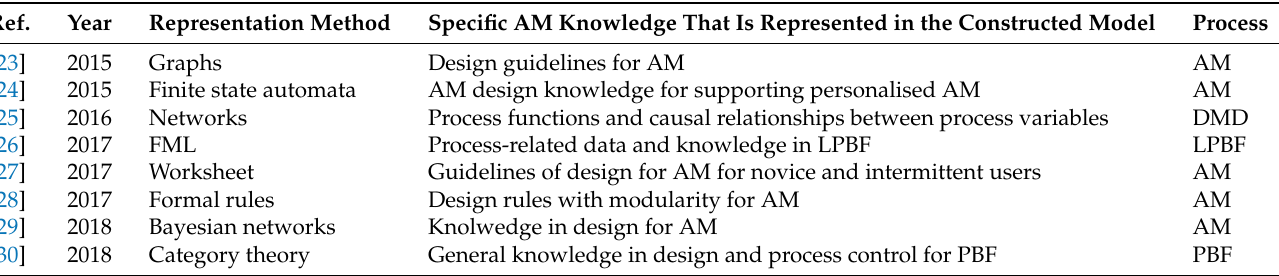
Table 1. Overview of existing models for AM knowledge representation.